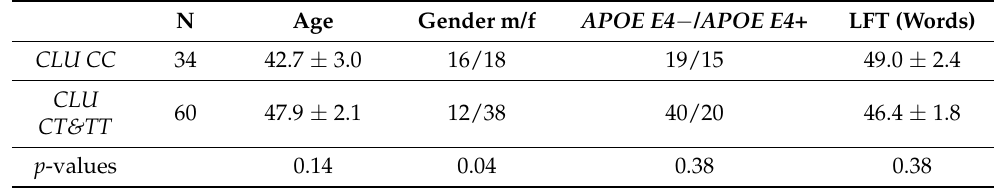
Table 1. Demographic information, APOE genotype, and letter fluency test (LFT) performance of nondemented individuals aged 19 to 80 years with different CLU genotypes.